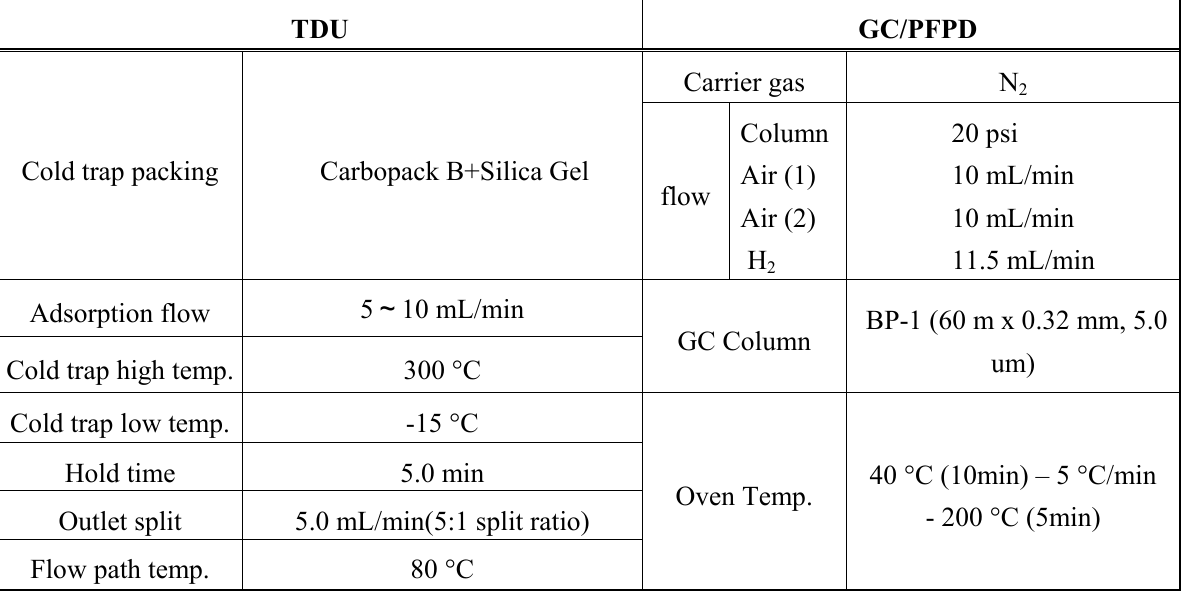
Table 3. Operational Condition of TDU-GC/PFPD for Reduced Sulfur